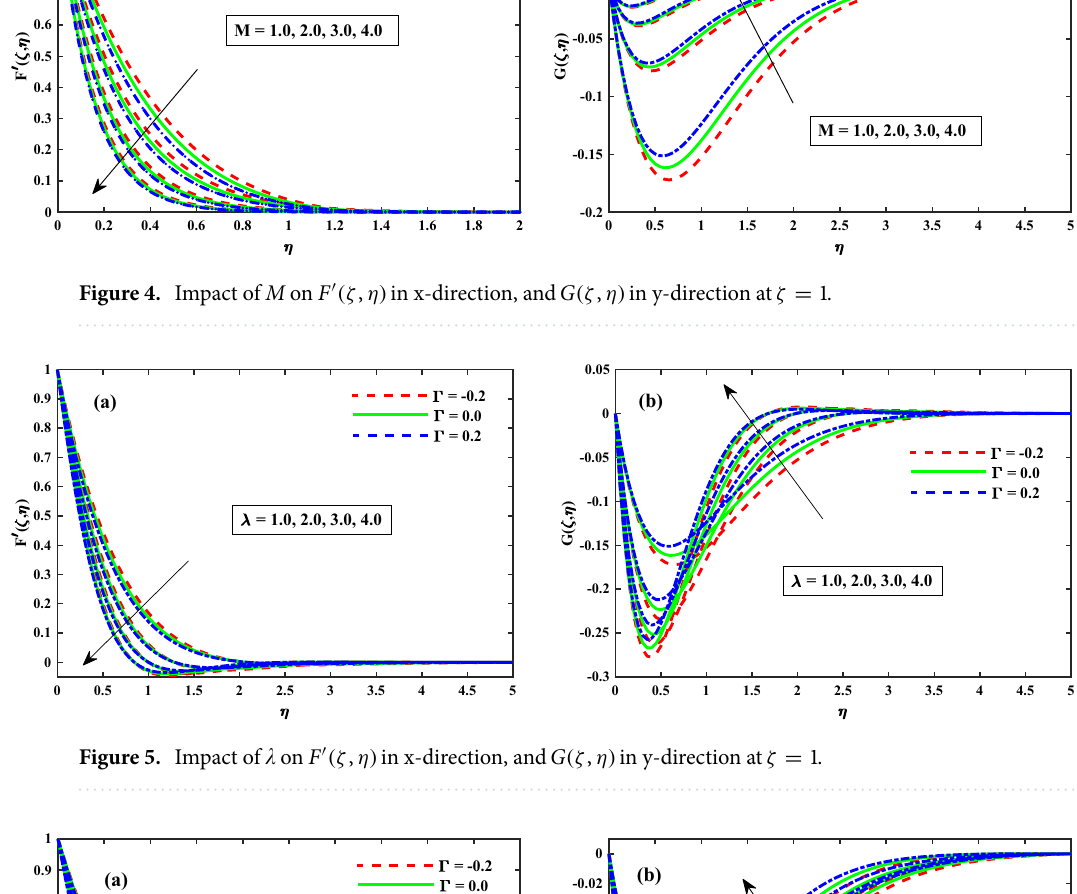
Figure 5. Impact of (cid:31) on F ′ (ζ , η) in x-direction, and G (ζ , η) in y-direction at ζ